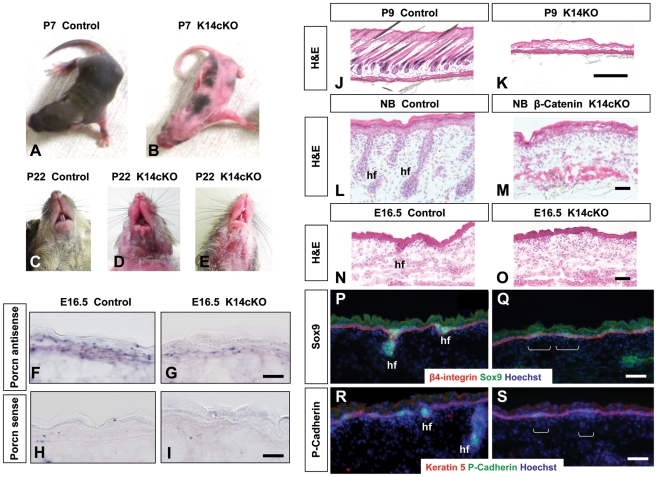
Phenotype of XPorcn-Ex3-7-flox/Y;Krt14-Cre mice.(A, B) Extensive alopecia of XPorcn-Ex3-7-flox/Y;Krt14-Cre (Krt14cKO) compared to wild type (control) at P7. (C–E) Variable dental phenotype (missing and hypoplastic teeth) in Krt14cKO mice. (F–I) RNA in situ hybridization with a Porcn antisense (F, G) and sense (H, I) riboprobe to E16.5 Krt14cKO (G, I) and control (F, H) skin showing reduced Porcn expression in mutant. (J, K) H&E staining of dorsal skin of Krt14cKO (K) and control (J) mice at P9 shows lack of hair follicles in the Krt14cKO mice. (L, M) H&E staining of dorsal skin from newborn (NB) β-catenin
flox/+;Krt14-Cre (β-catenin Krt14cKO; M) and control (L) mice also shows lack of hair follicles in the mutant. (N, O) H&E staining of skin from Krt14cKO (O) and control (N) mice at E16.5 shows that the early step of hair follicle morphogenesis does not take place in the Krt14cKO mice. hf, hair follicle. (P, Q) Immunostaining of skin at E16.5 shows that the Krt14cKO epidermis (Q) lacks Sox9-positive cells, which mark the hair follicle from the earliest budding stage (placode). (R, S) Skin of Krt14cKO epidermis (S) at E16.5 also lacks P-cadherin-positive cells, also indicating that placode formation is drastically compromised. Scale bars: F–I and L–S, 50 µm; J and K, 500 µm.